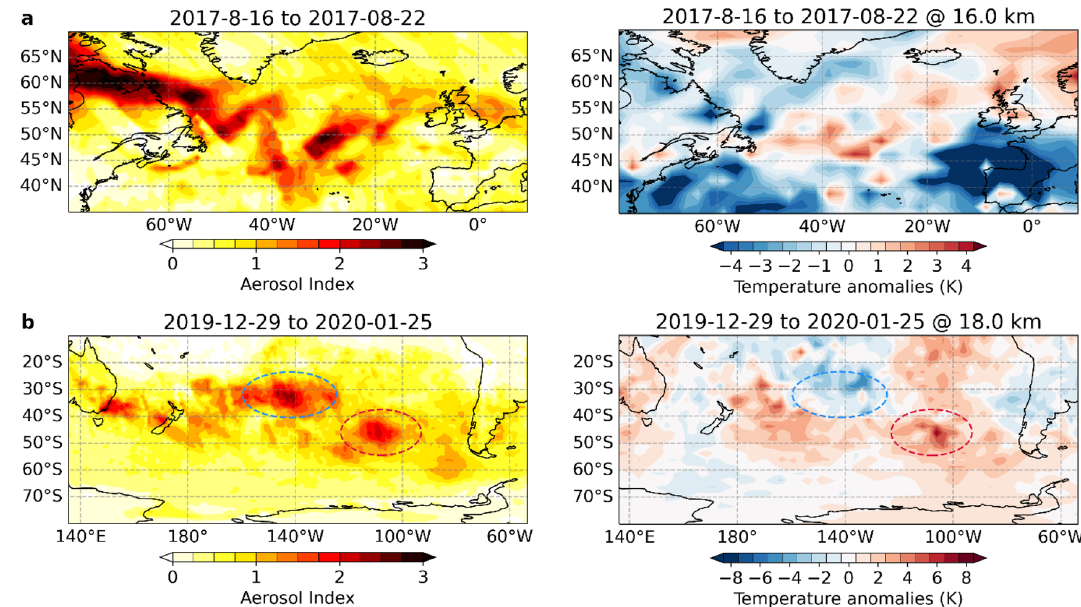
Figure 4. Regional temperature anomalies shortly after the wildfire events. ( a ) Mean aerosol index (AI) and RO temperature anomalies in the lower stratosphere (16 km) in the Northern Atlantic region for the week from August 16 to August 22, 2017. ( b ) Same as ( a ) but for the Southern Pacific region and at an altitude of 18 km for the weeks from December 29, 2019 to January 25, 2020. Note the different temperature ranges in ( a ) and ( b